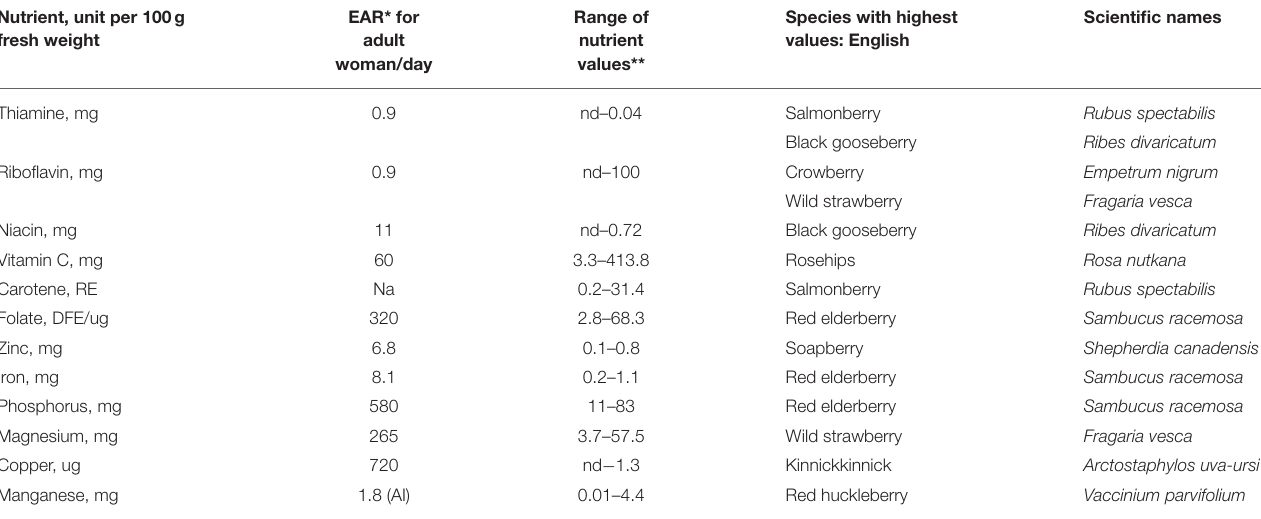
Species with highest values: English